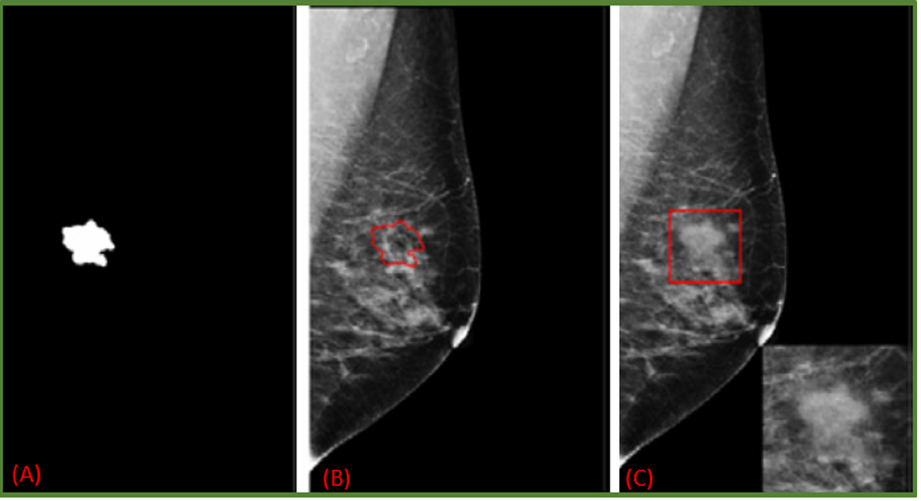
Figure 9. Private Dataset: Given mask image ( A ); normal mammogram image ( B ); generated mammogram image with synthetic mask ( C ) [55].